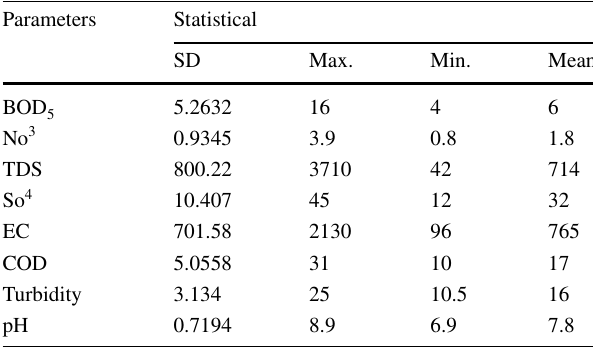
Fig. 2 The location of the five sampling stations in the study area Table 1 Summary of statistical parameters in the area